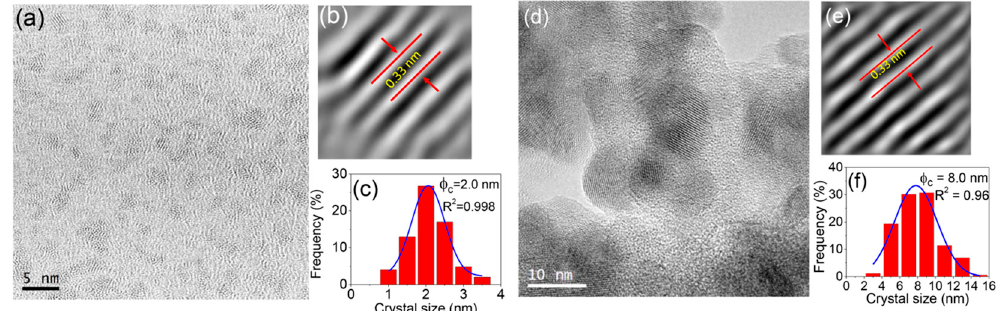
Figure 6. ( a ) High resolution transmission electron microscopy (HRTEM) micrograph, ( b ) lattice distance and ( c ) crystal-size distribution of 80SiO 2 -20LaF 3 0.5Er 3+ thin film treated at 550 °C for 1 min. ( d ) HRTEM micrograph, ( e ) lattice distance and ( f ) crystal-size distribution of 80SiO 2 -20LaF 3 0.5Er 3+ self-supported layer treated at 550 °C for 1 min.